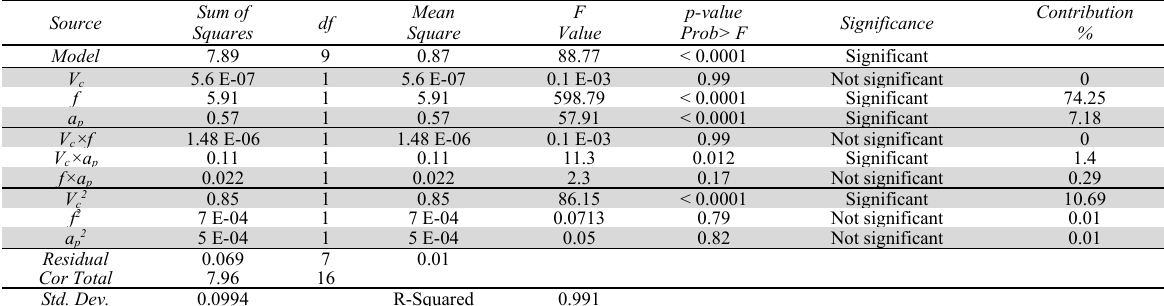
Analysis of variance for surface